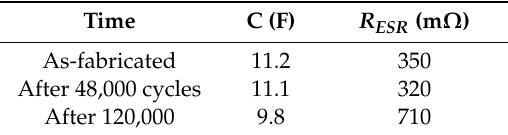
Table 2. Electrical parameters capacitance C and equivalent serial resistance R ESR of the tested prototype